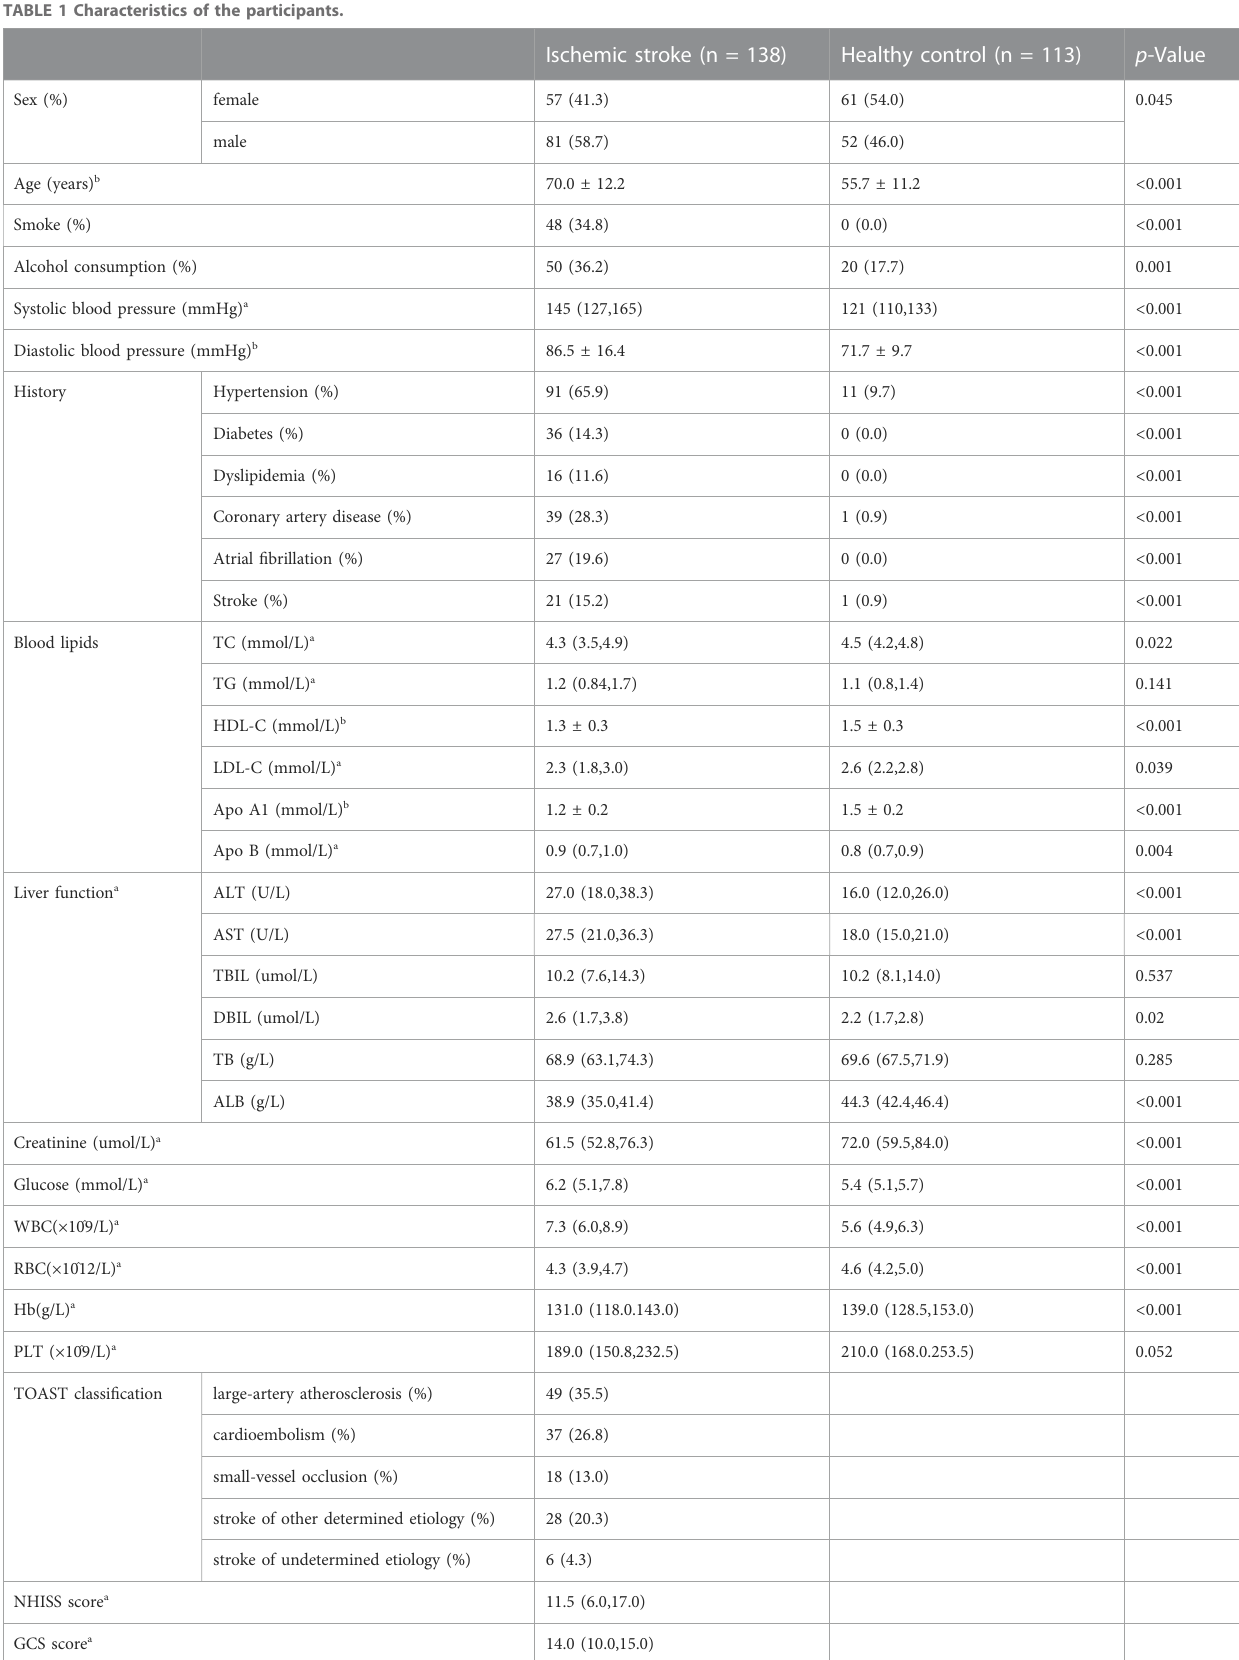
TABLE 1 Characteristics of the